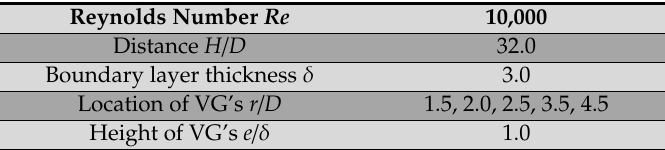
Table 5. Experimental conditions for locations of